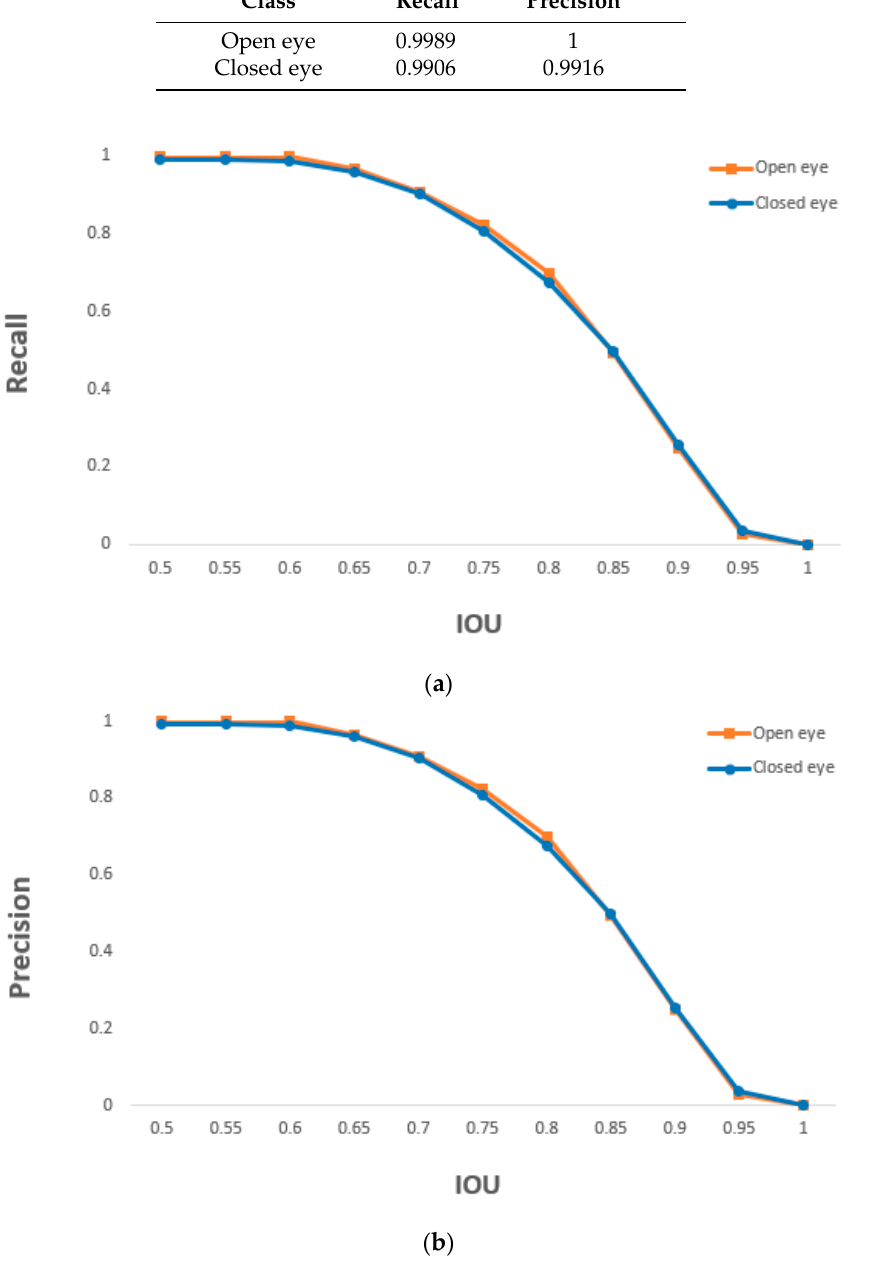
Figure 18. Graphs of ( a ) recall and ( b ) precision of the detection of open and closed eye according to IOU thresholds.